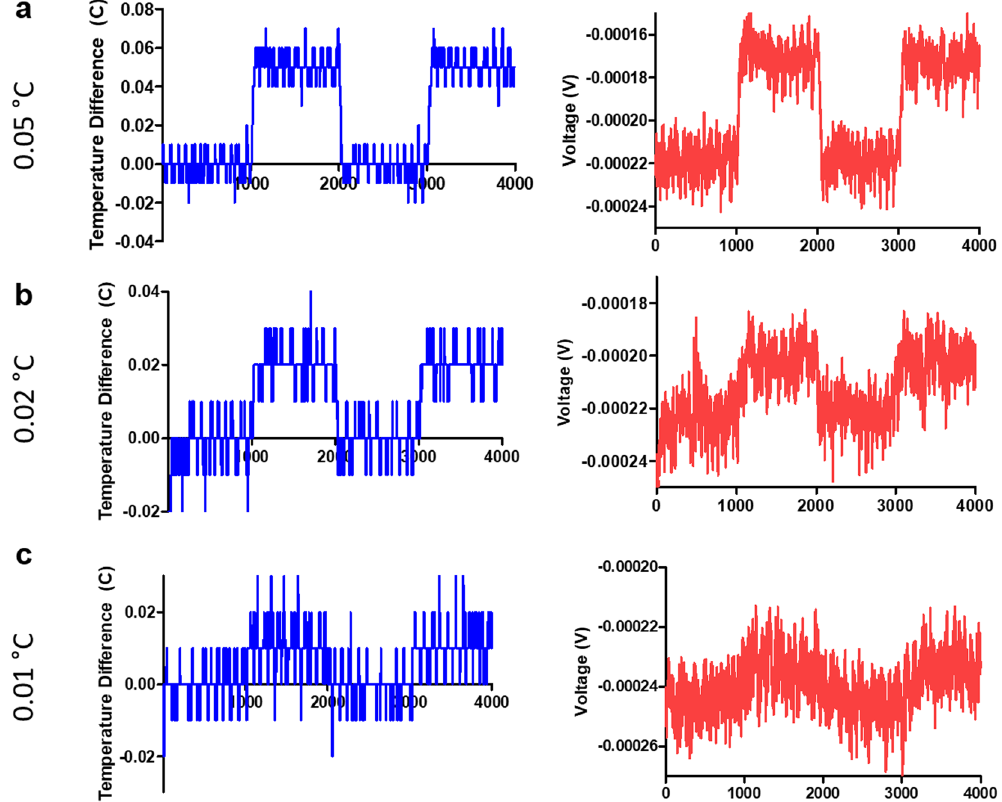
Figure 5. Temperature step measurements. The temperature was raised and lowered by ( a ) 0.05 °C, ( b ) 0.02 °C, and ( c ) 0.01 °C using a hot plate. The reference temperature was obtained using the built-in thermistor of the hot plate (left, in blue) while the voltage was measured on the device (right, in red). The measurements show clear step-shift in voltage level down to the temperature change of 0.01 °C, supporting that 0.01 °C sensitivity can be achieved with this